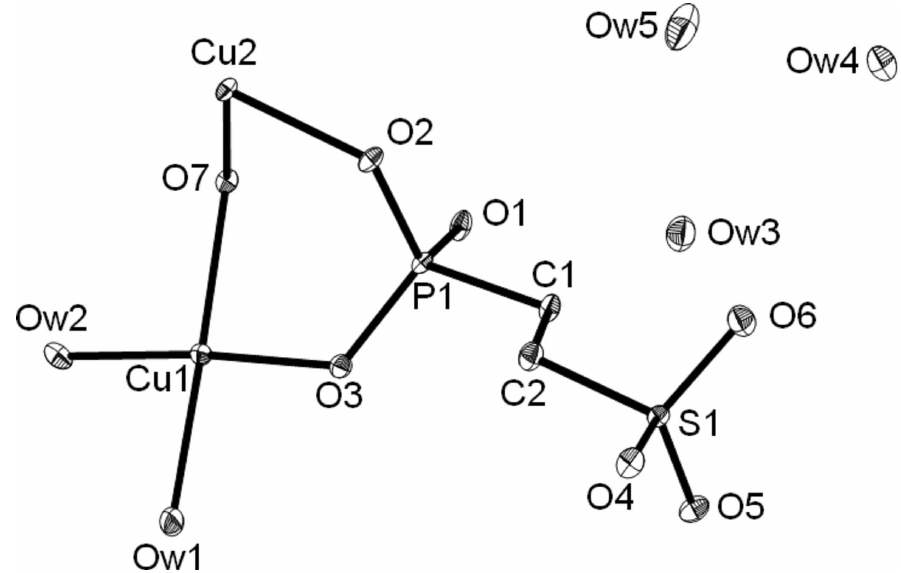
Figure 1 Asymmetric unit of the title compound. Displacement ellipsoids are drawn at the 50% probability level.